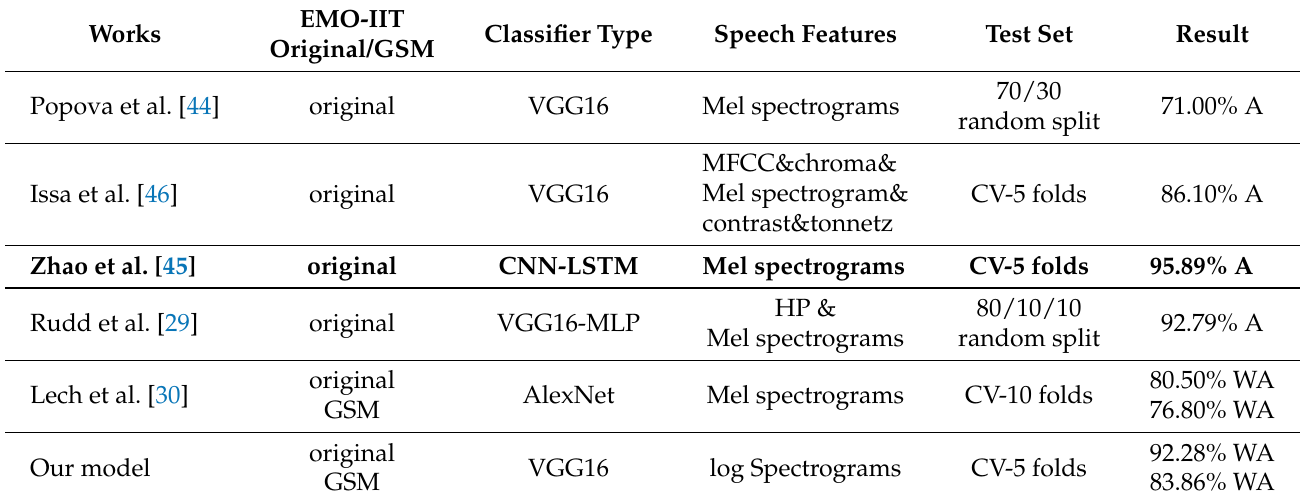
Table 10. Comparison of EMO-DB results (bold marks the best